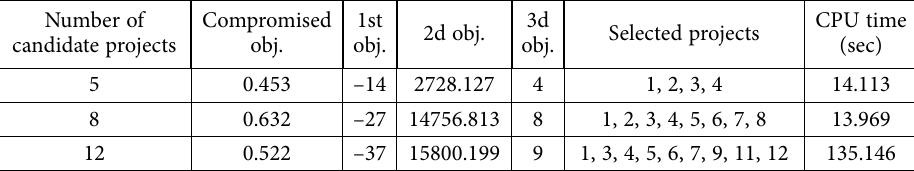
Table 1. Brief results for different test